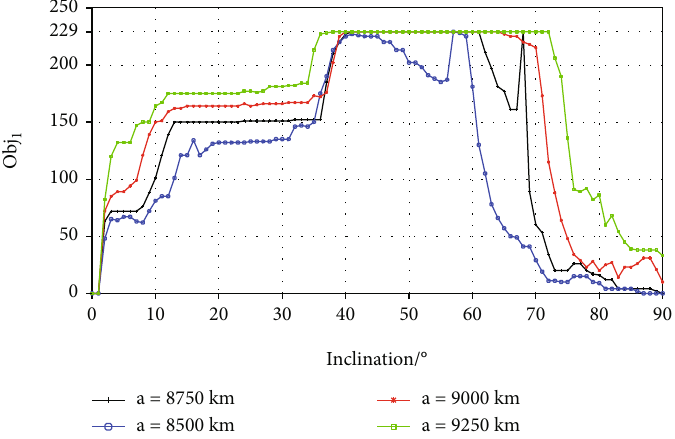
Figure 3: E ff ect of the inclination on Obj